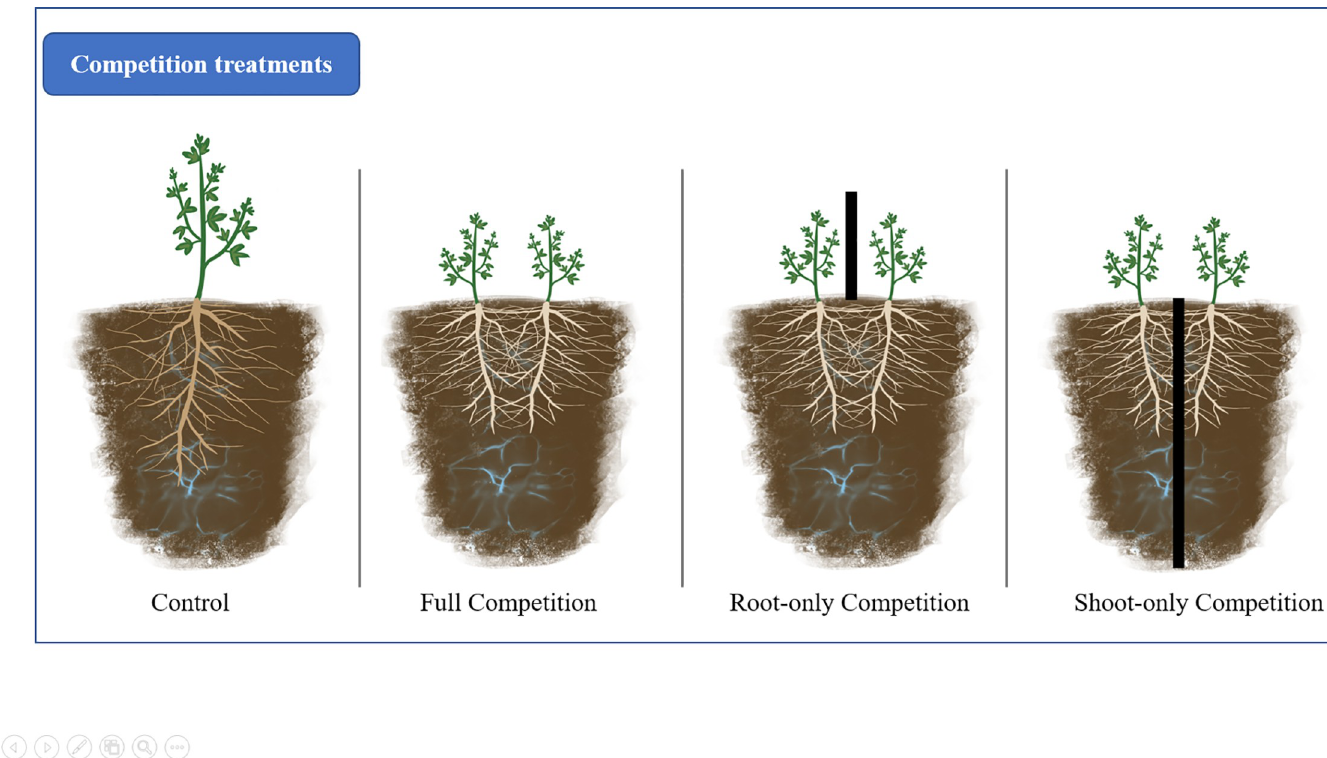
Fig 1. Study treatments. Competition treatments of root-only, shoot-only, full competition and, monoculture of partition studies.